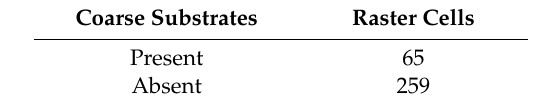
Figure 7. Examples of coarse sediment ( a ) absence and ( b ) presence in underwater video. Table 1. Coarse substrate observations from underwater video frames.